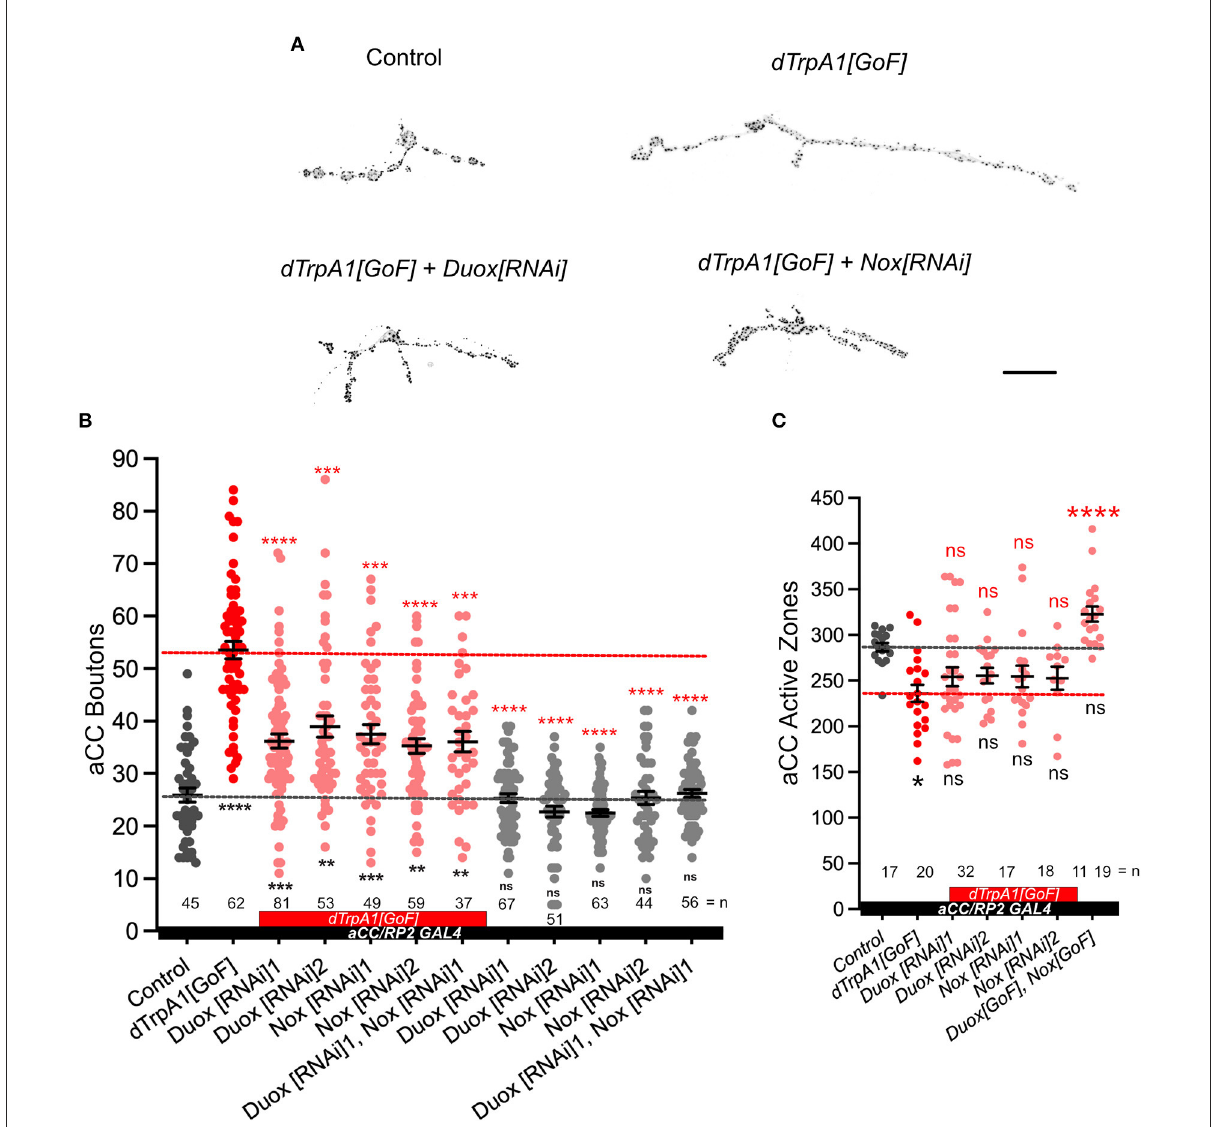
FIGURE1 NADPH oxidases, dDuox and dNox, are both required for activity-regulated growth of the neuromuscular junction. (A) Representative images of aCC motoneuron terminals on their target muscle, DA1 (muscle 1, according to Crossley, 1978) in third instar larvae [100h after larva hatching (ALH)] labeled with a 20xUAS-6xmCherry reporter expressed by aCC/RP2-Gal4 (see Section 4) and active zones (black spots): control ( aCC/RP2-Gal4/ + ); dTrpA1 overactivated; dTrpA1 overactivated while either Duox or Nox is concomitantly knocked down via targeted RNAi [“ dTrpA1[GoF] + Duox[RNAi] ” and “ dTrpA1[GoF] + Nox[RNAi] ”]. (B) Dot-plot quantification shows NMJ bouton number increases in response to cell-specific activity increases. This phenotype is rescued by simultaneous NADPH oxidase knockdown. (C) Dot-plot quantification shows active zone number decreases following overactivation [ dTrpA1[GoF] ], but there are not significant differences when manipulating NADPH oxidases. Mean ± SEM, ANOVA, * p < 0.05, ** p < 0.01, *** p < 0.001, and **** p < 0.0001. ns = not significant. Red asterisks indicate comparisons with the dTrpA1[GoF] group, while black indicate comparison with the un-manipulated wild type control. Scale bar = 20 µ m.